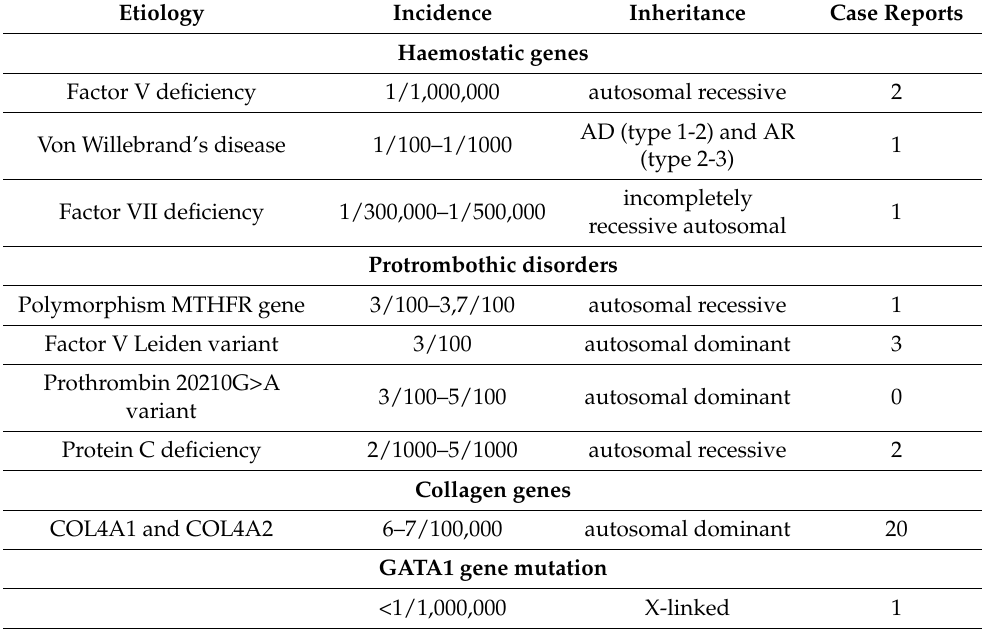
Table 1. Genetic causes of fetal intracranial haemorrage: incidence, inheritance and numbers of case